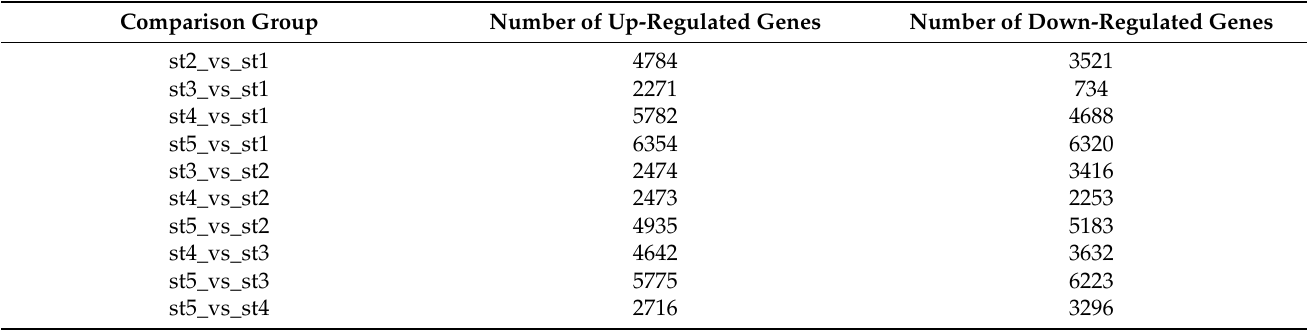
Table 1. The number of differentially expressed genes in different developmental